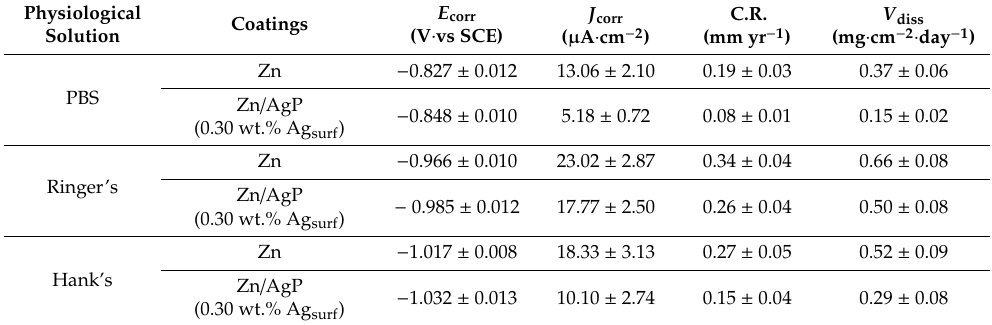
Table 4. Corrosion parameters of Zn coatings and Zn / AgP (0.30 wt.% Ag surf ) composite coatings in di ff erent physiological solutions, obtained from the polarization